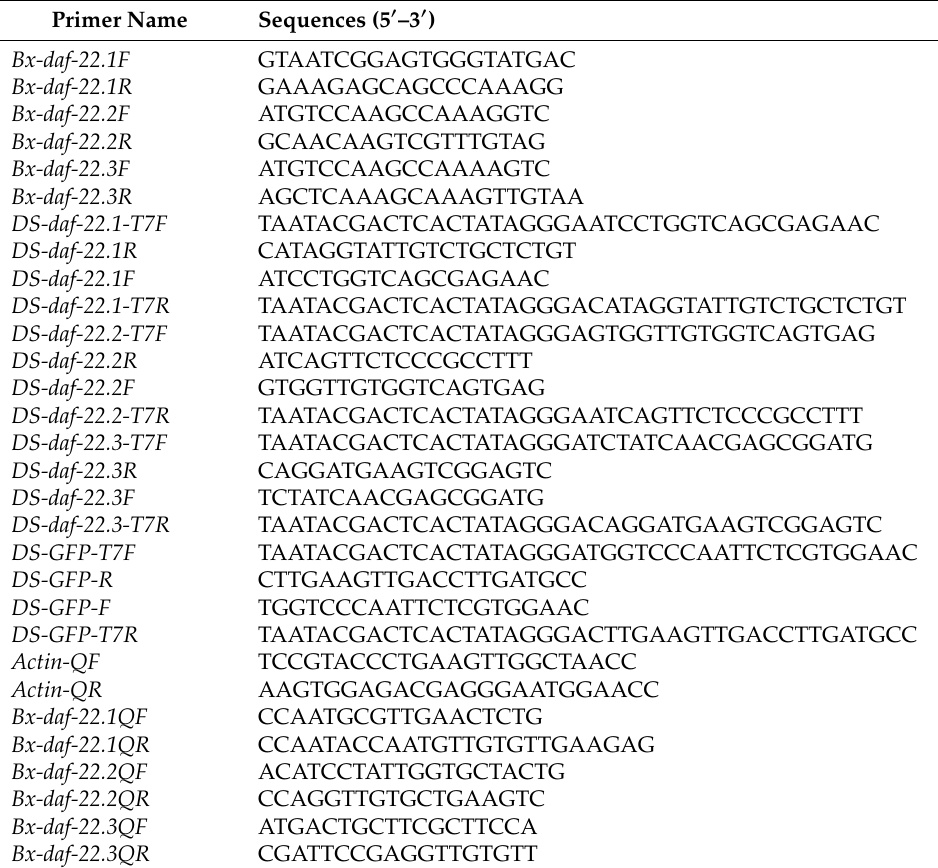
Table 1. Primers used in the